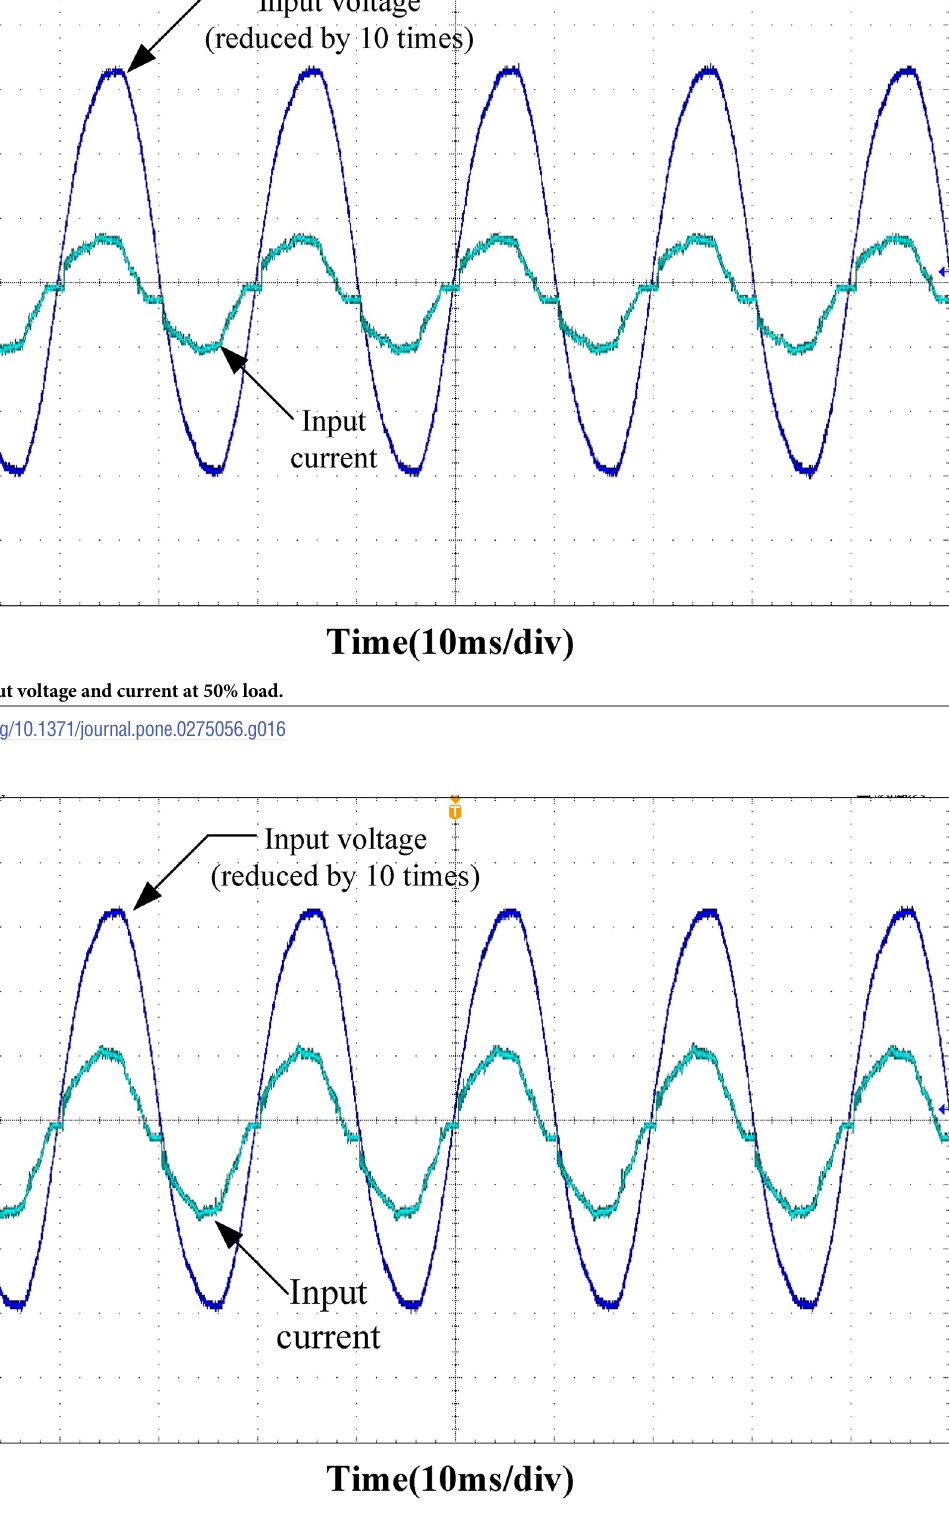
Fig 17. Input voltage and current at 75%